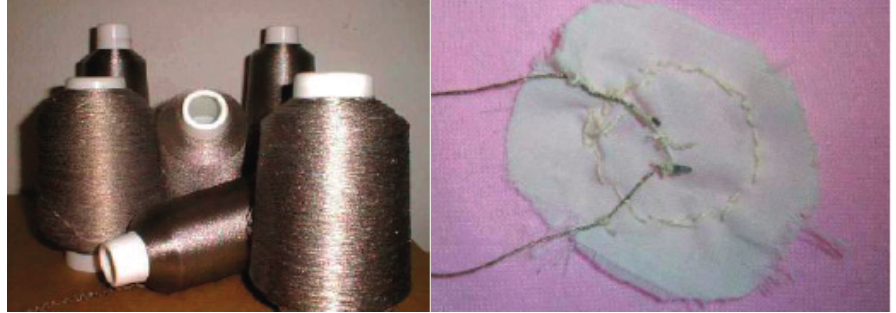
Figure 10. The conductive textile wires ( left ) and the connection of the sensor and the conductive wires ( right ) [10]. Copyright © 2010 Association for Computing Machinery,